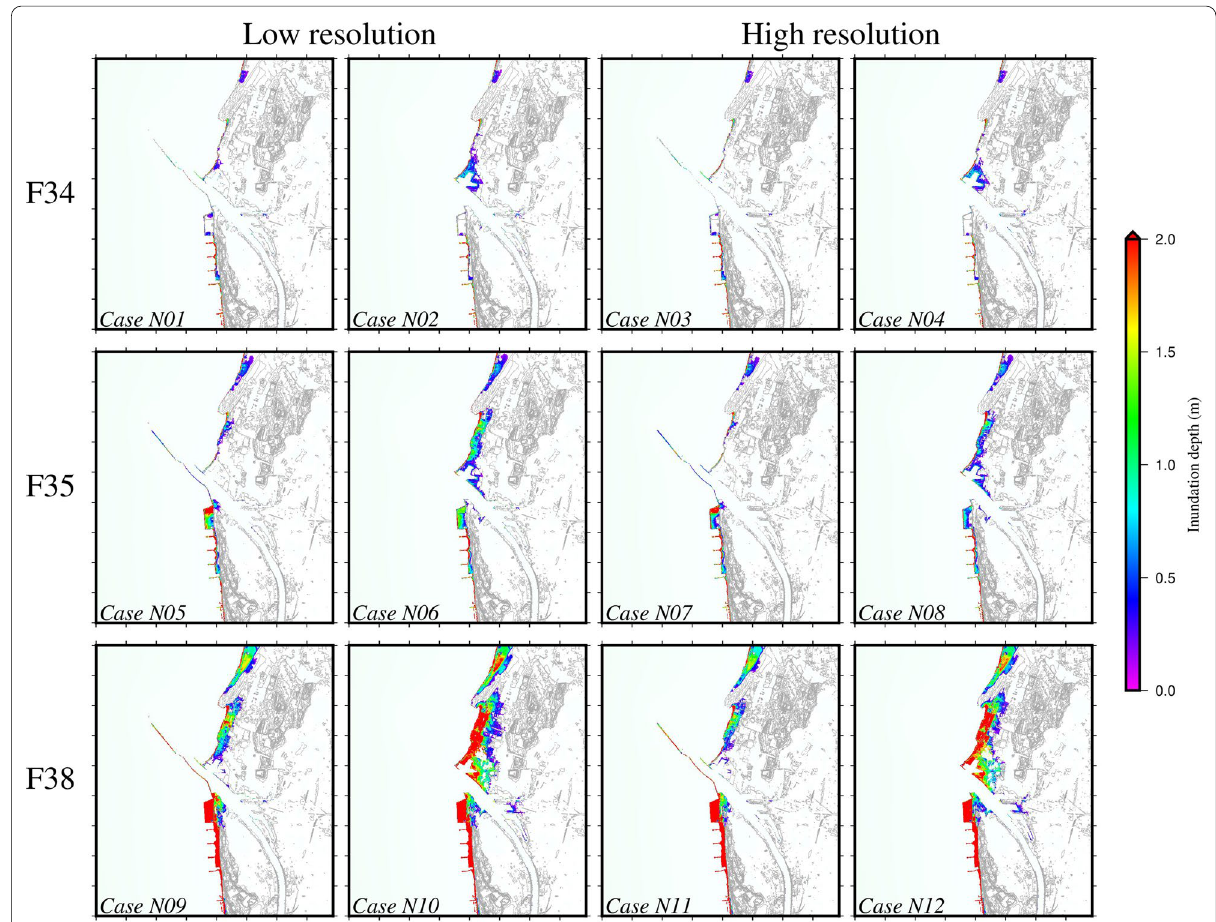
Fig. 10 Distribution of the maximum inundation depth at Niigata City generated up to 45.0 min after the earthquakes. The displayed areas correspond to the areas specified by the blue squares in the bottom-right panel in Fig. 3; the thick interval was 1